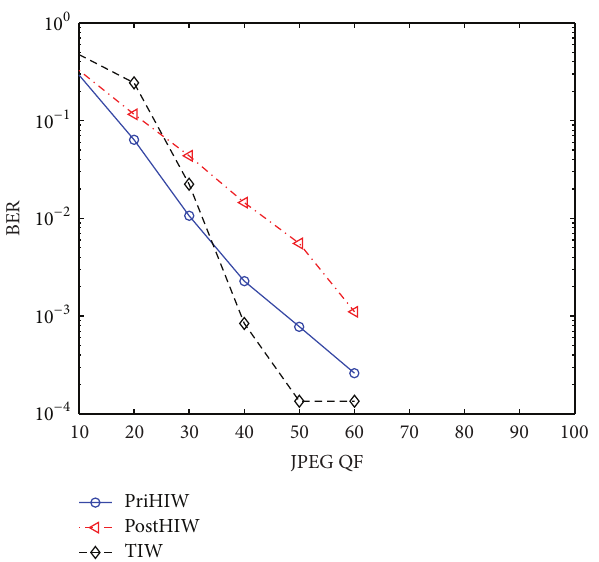
Figure 8: Performance comparison for the PriHIW, PostHIW, and TIW against JPEG compression.